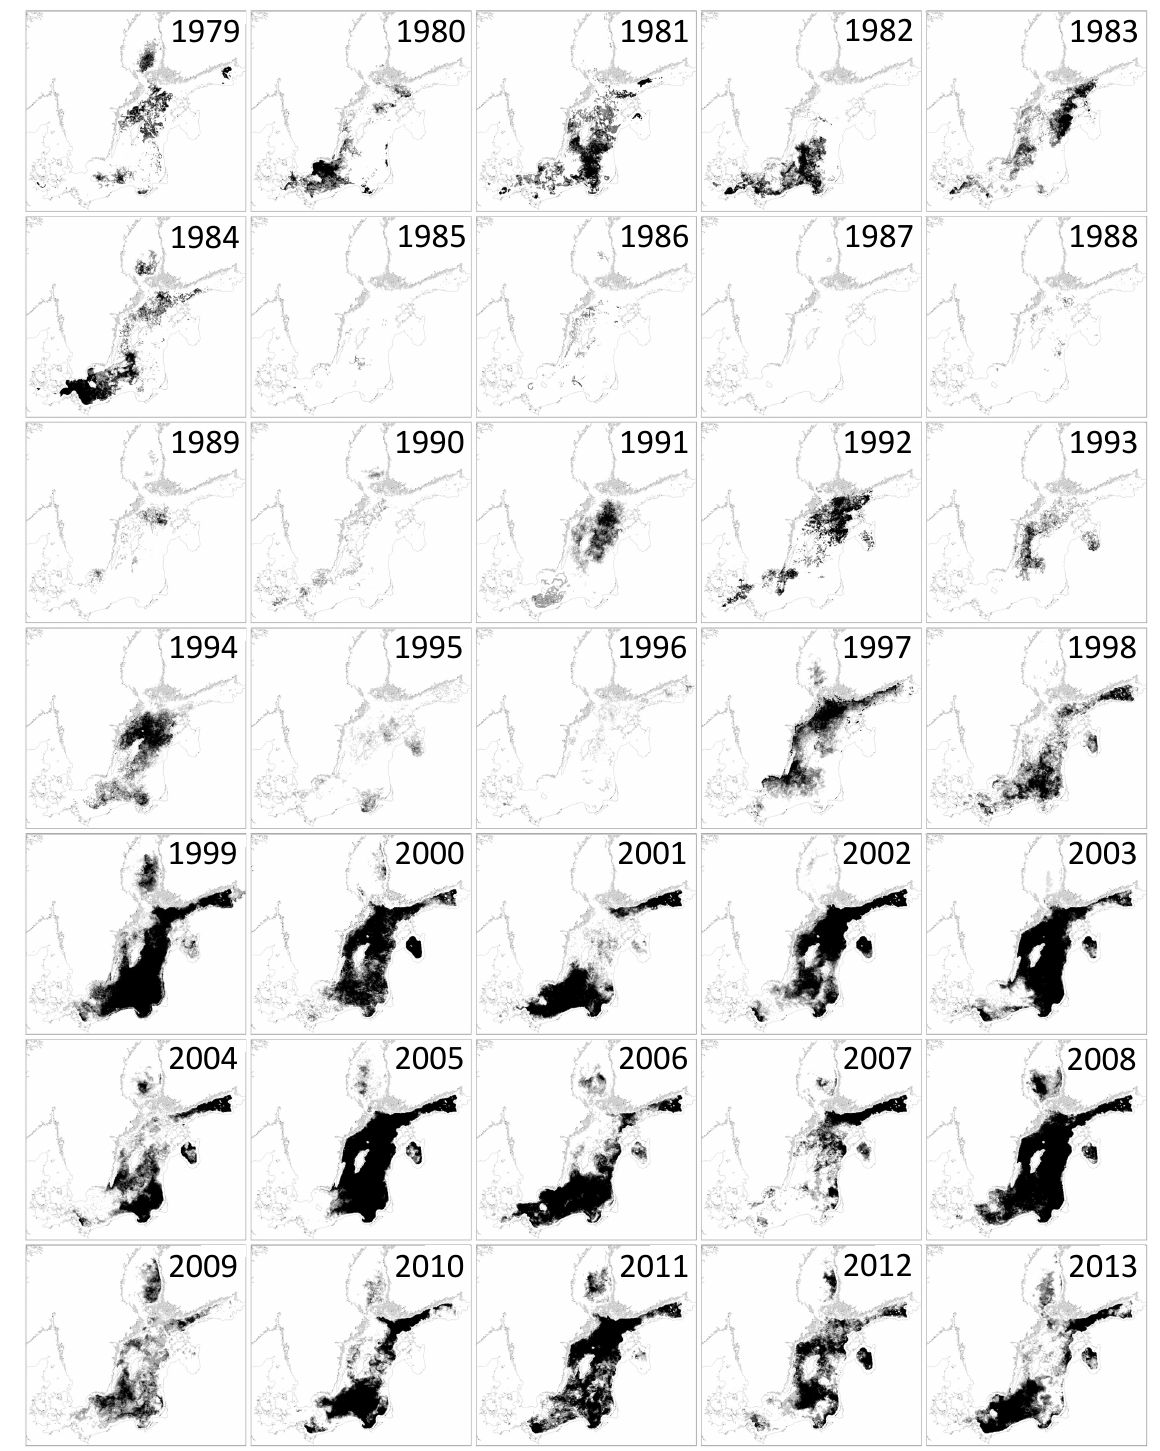
Figure 13. Maps of the mean July–August FCA in the Baltic Sea, 1979–2013. Gray-scale from light to dark corresponds to increasing FCA.